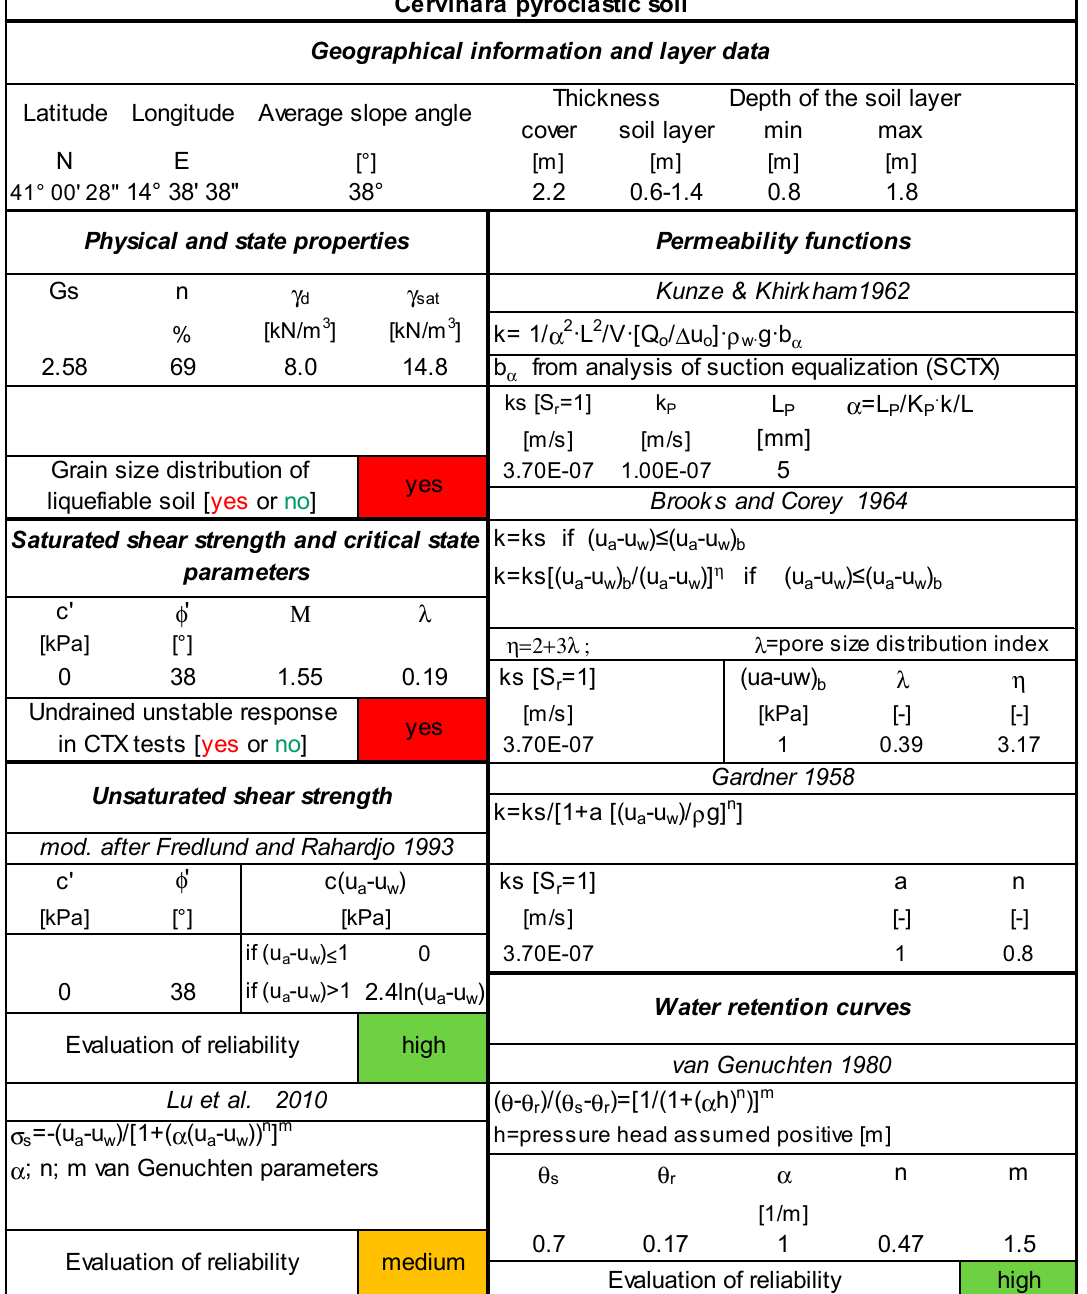
Figure 8. Soil database for Cervinara pyroclastic ash (evaluation of reliability: high if relationship reproduces the trend of experimental data; medium if relationship reproduces only qualitatively the trend of experimental data; low if relationship does not reproduce the trend of experimental data at all).